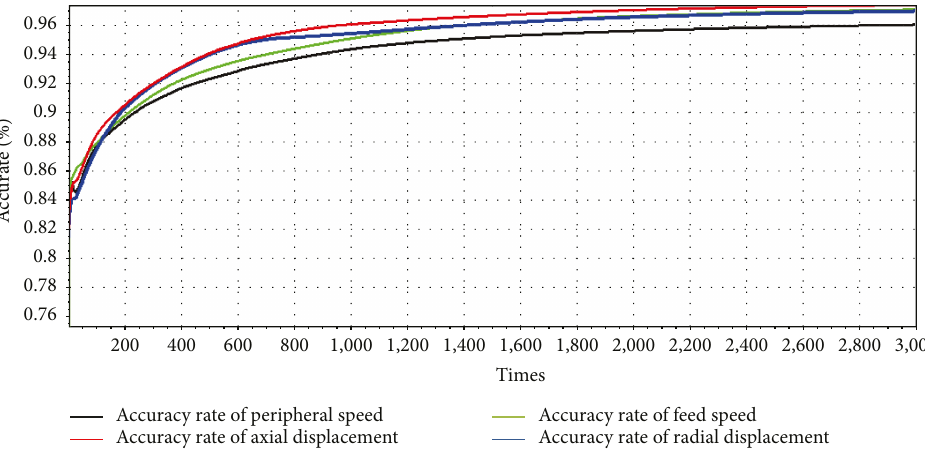
Figure 14: Trends of accuracy changing of deep learning neuron network for casting block grinding with training times